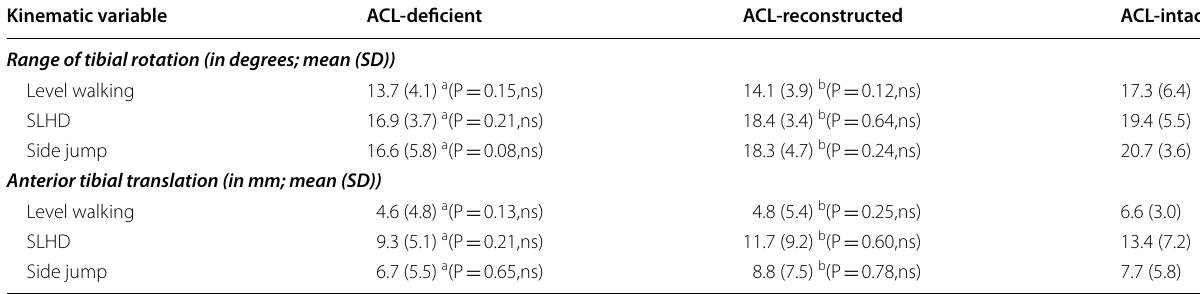
a paired t-test results comparing the ACL-deficient knee to the contralateral ACL-intact knee b paired t-test results comparing the ACL-reconstructed knee to the contralateral ACL-intact knee ACL Anterior cruciate ligament, SLHD Single-leg hop for distance, SD Standard deviation, mm Millimeter, ns Non-significant